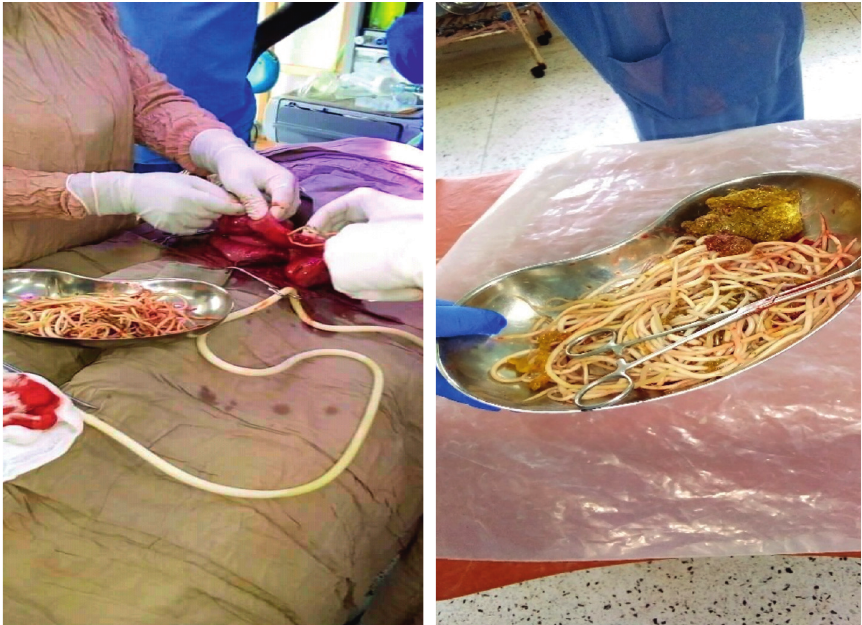
Figure 1: Physical appearance of Ascaris Lumbricoides extracts during exploratory